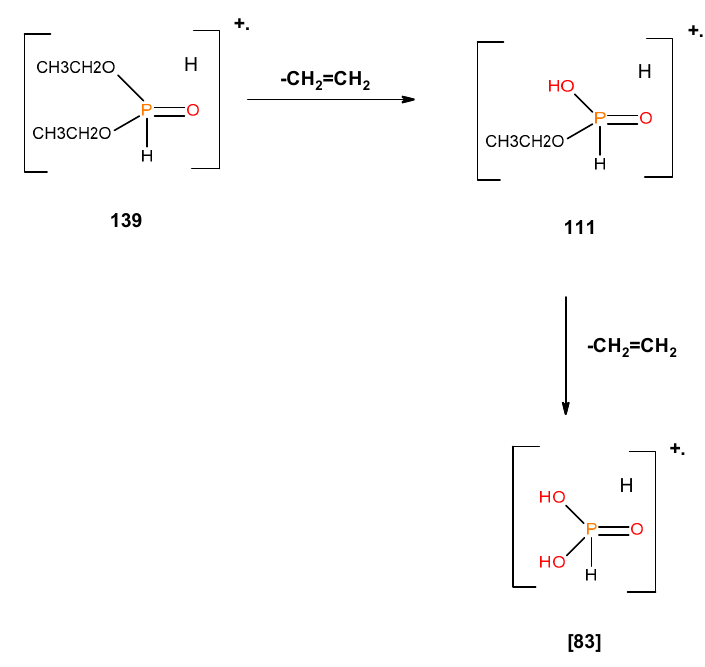
Figure 10. Possible fragmentation pattern for DEPi.